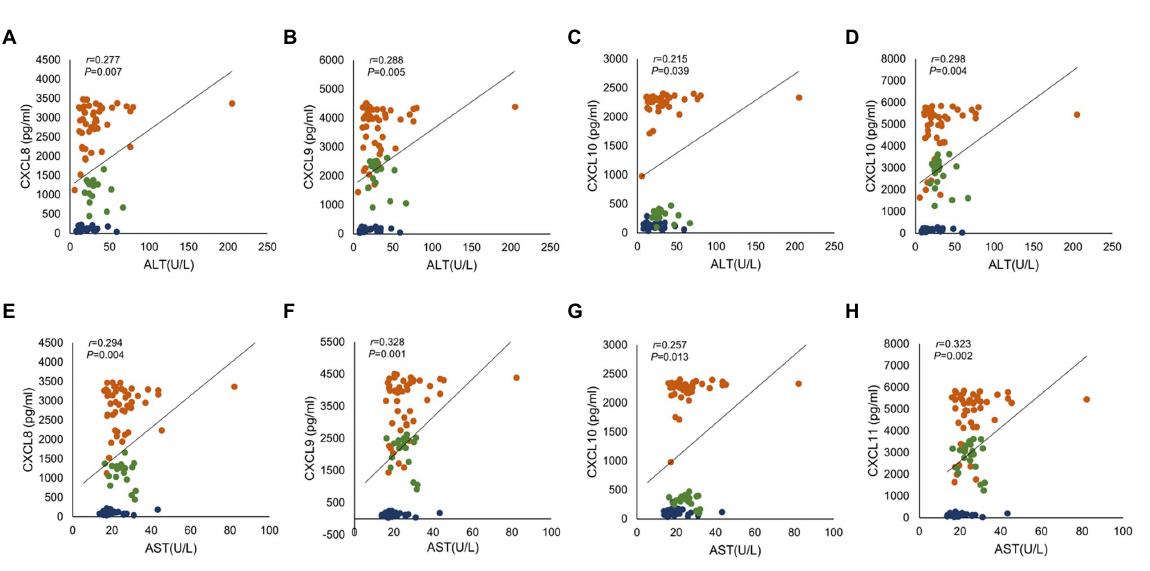
FIGURE 4 The correlation analysis between serum chemokines and ALT and AST. Association of four chemokines with ALT and AST in 28 healthy subjects, 45 CHB patients and 20 HBV-free patients. Correlation with ALT: (A) CXCL8, (B) CXCL9, (C) CXCL10 and (D) CXCL11; Correlation with AST: (E) CXCL8, (F) CXCL9, (G) CXCL10 and (H) CXCL11. Orange indicates CHB group, green indicates HBV-free group and blue indicates Healthy group. Comparisons were made using Pearson correlation